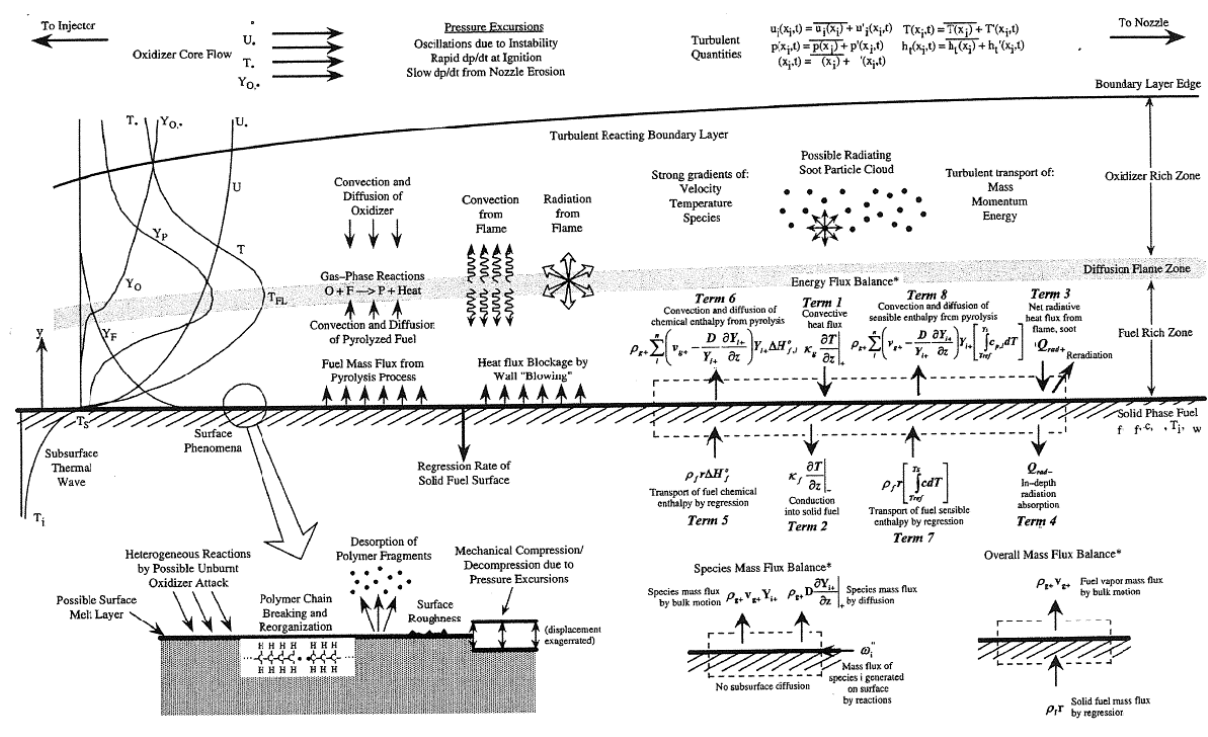
Figure 1. Physical processes involved in hybrid rocket combustion from Chiaverini